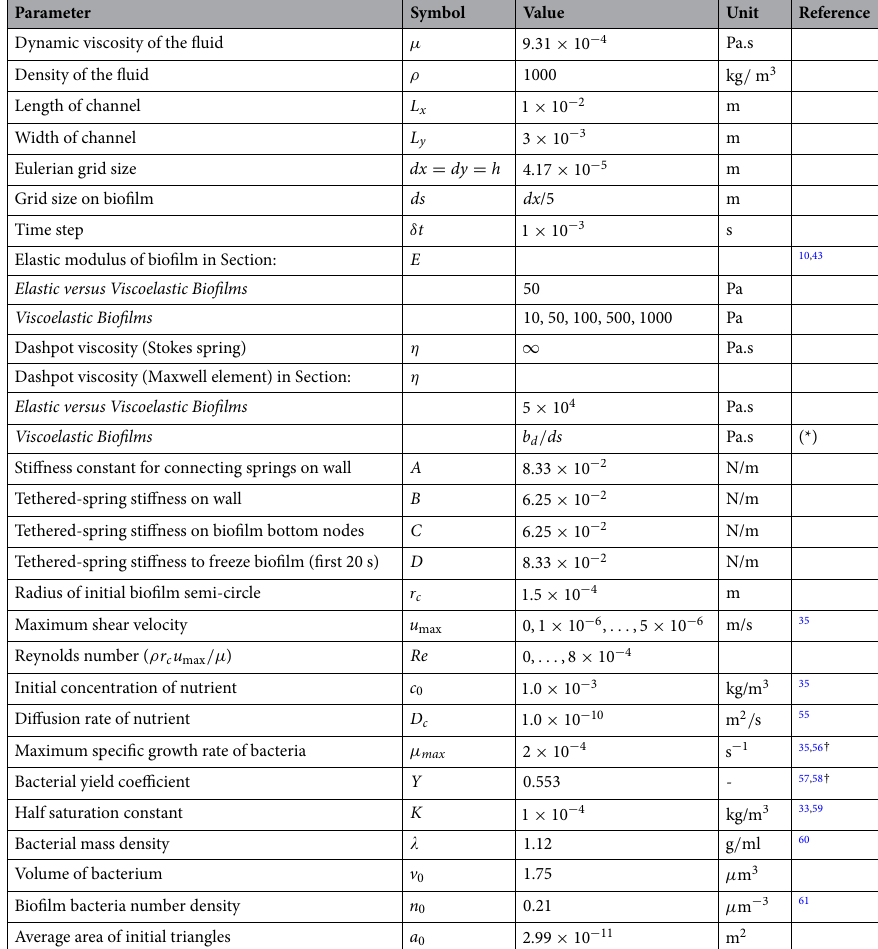
Table 1. Parameters used in numerical simulations. (*) The calculation of the drag coefficient b d is shown at the end of Supplementary Information-2: Viscoelastic Parameters. ( † ) These values are chosen within the range of the values reported in the corresponding